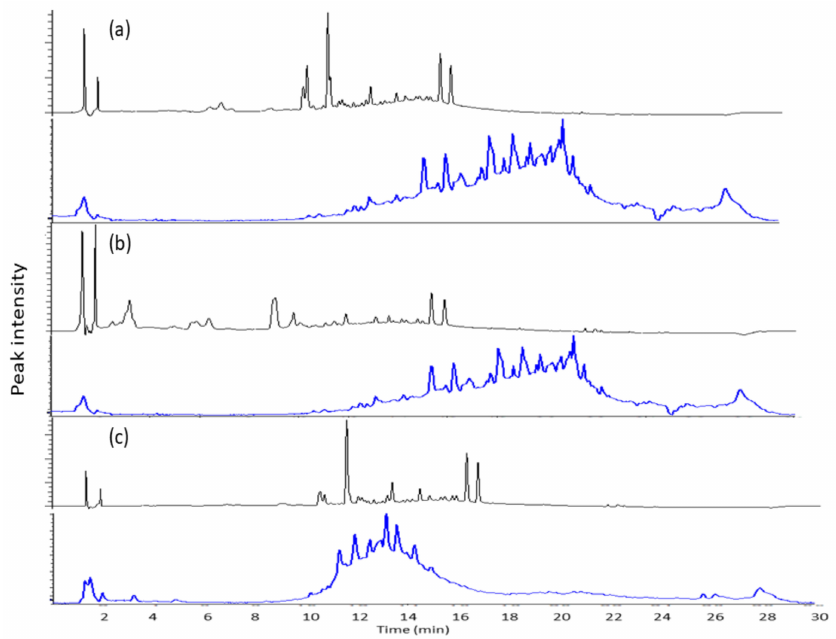
Figure 3. Chromatograms (black line) and total ion chromatograms (blue line) of mass spectrometer for organic fractions from ethyl acetate ( a ), butanol ( b ), and chloroform ( c